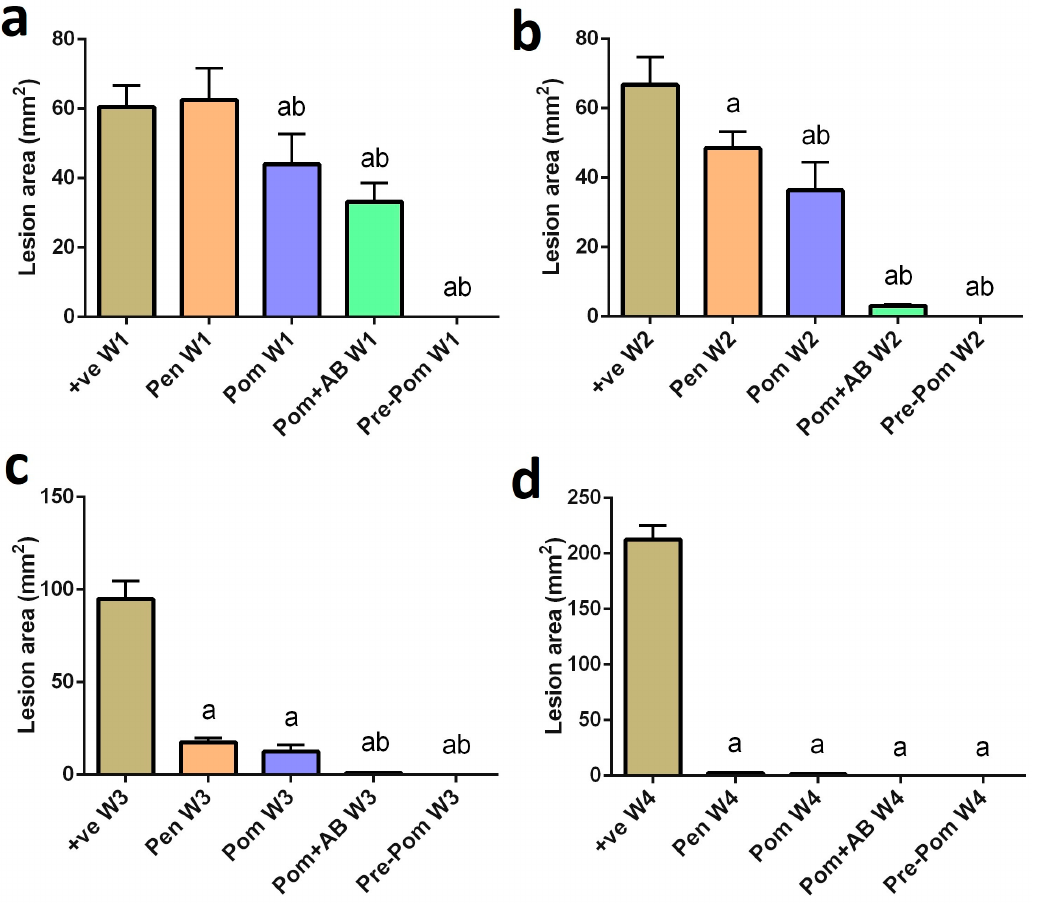
Figure 3. Lesion size in mouse skin one ( a ), two ( b ), three ( c ), and four ( d ) weeks after infection.